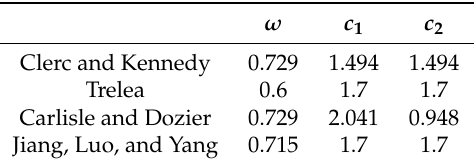
Table 4. Proposed PSO